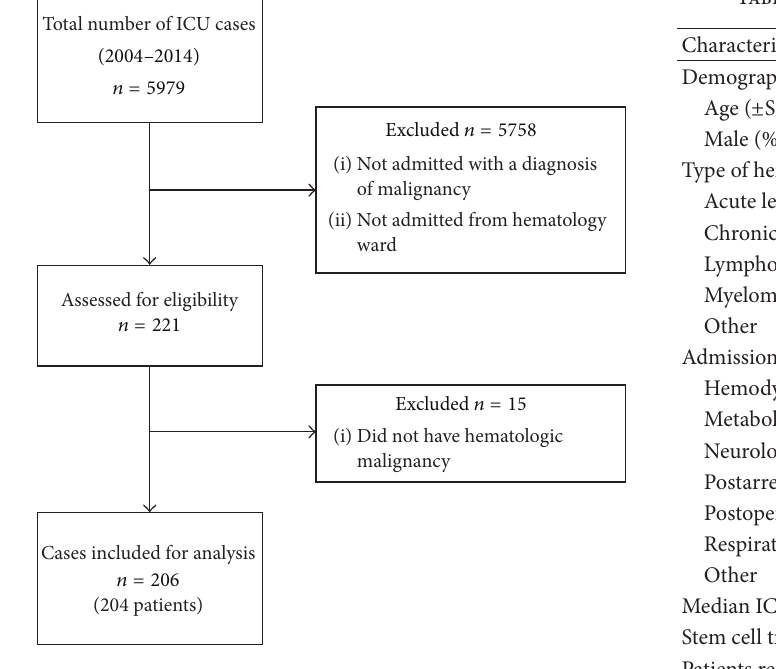
Figure 1: Selection of study participants.